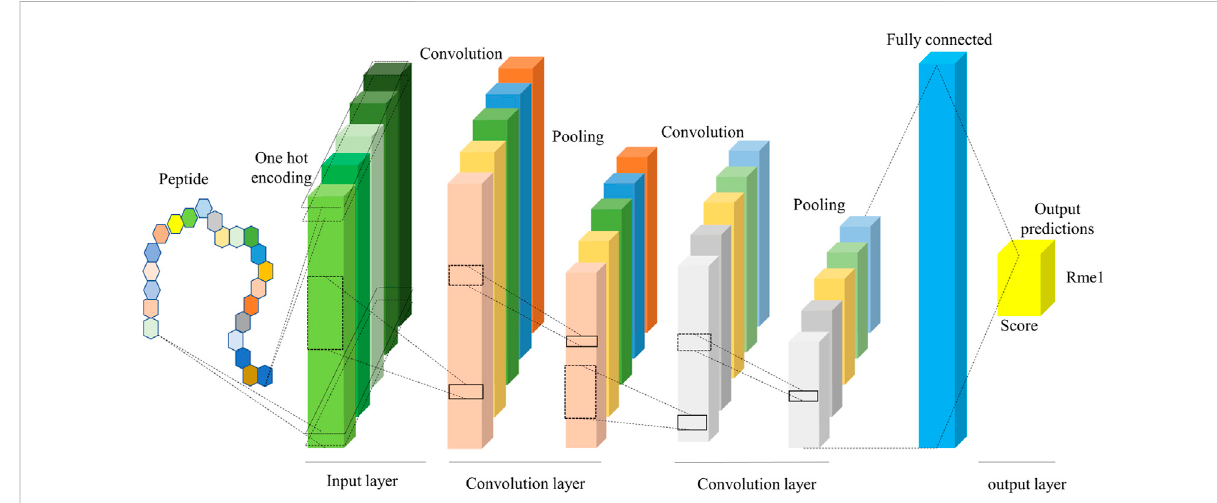
FIGURE 2 The framework of the CNN model. It includes input, convolution, and output layers, where the convolution layer extracts the features from the peptide sequence.